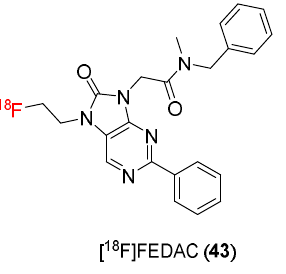
Figure 5. Structures of TSPO ligands containing